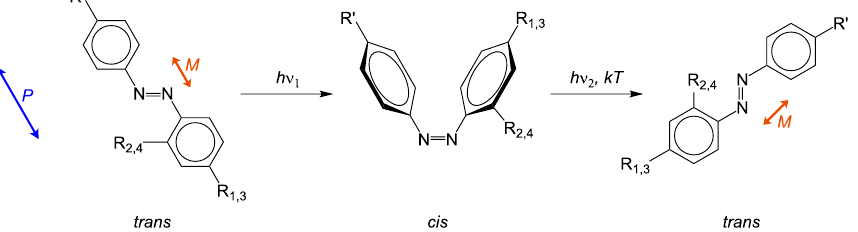
Figure 1. Photo-isomerization of azo chromophores. Light can not be absorbed, if polarization P plane is perpendicular to transition dipole moment M